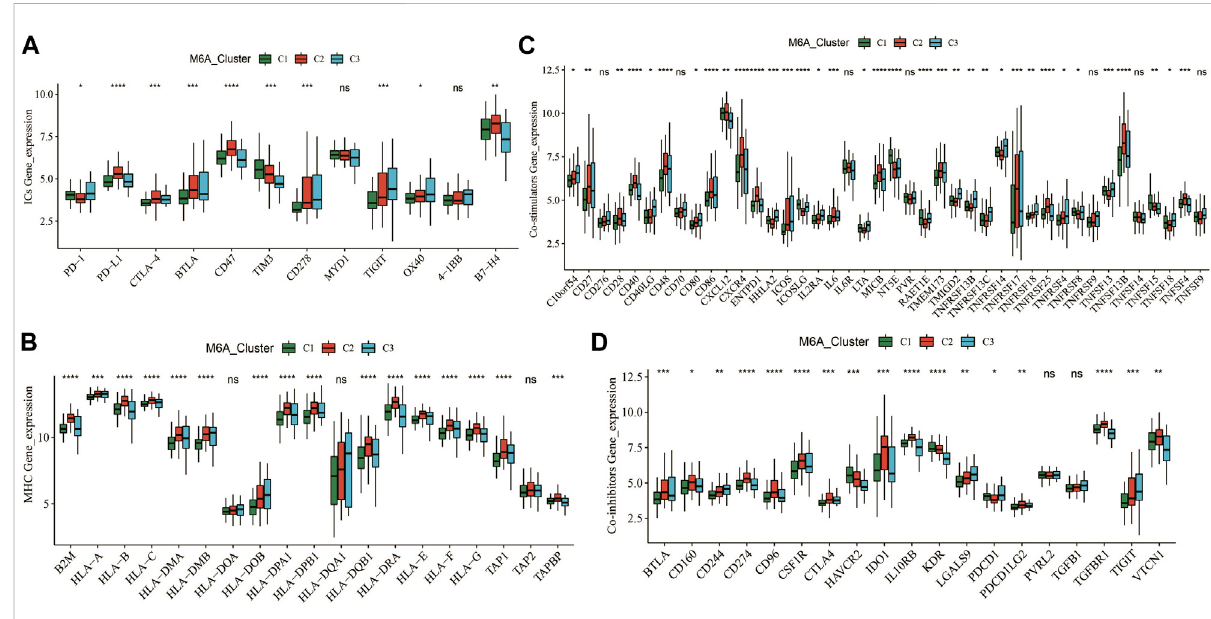
FIGURE 5 Expression patterns of typical immune-related genes. (A – D) Differential expression of immune checkpoint, MHC, co-suppression and co- stimulatory genes among different m6A clusters. * means p less than 0.05; ** means p less than 0.01, *** means p less than